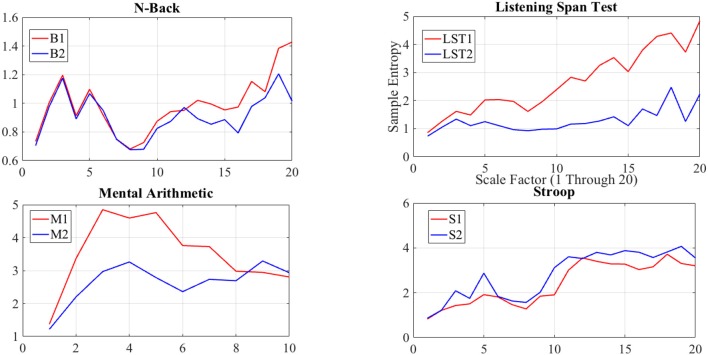
Grand averages of the mutli-scale entropy (MSE) values of the NIRS time series data of our participants. We use the pattern length m = 2, similarity criterion r = 0.15 and the range of 1 through 20 for the scale factor, as suggested by Goldberger et al. (2000).